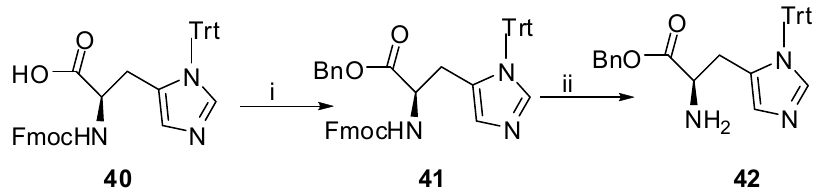
Scheme 7. Synthesis of compound 42